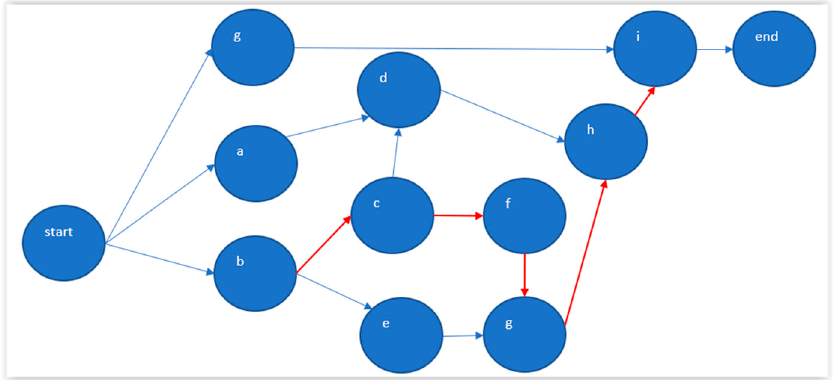
Figure 5. Critical path for knowledge about the EU perception.